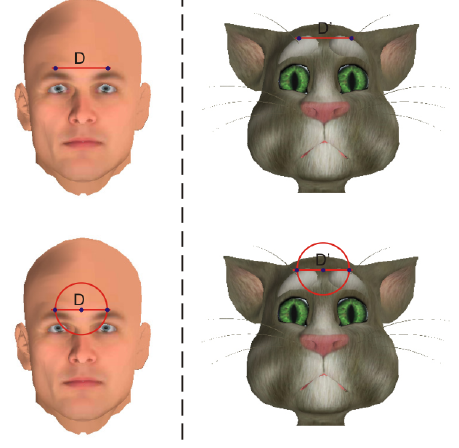
Figure 19. Application of radius definition rules.